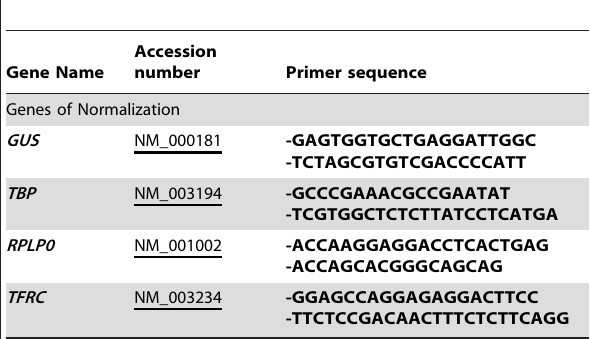
Table 2. Forward and reverse primers sequences for signature and normalization genes.